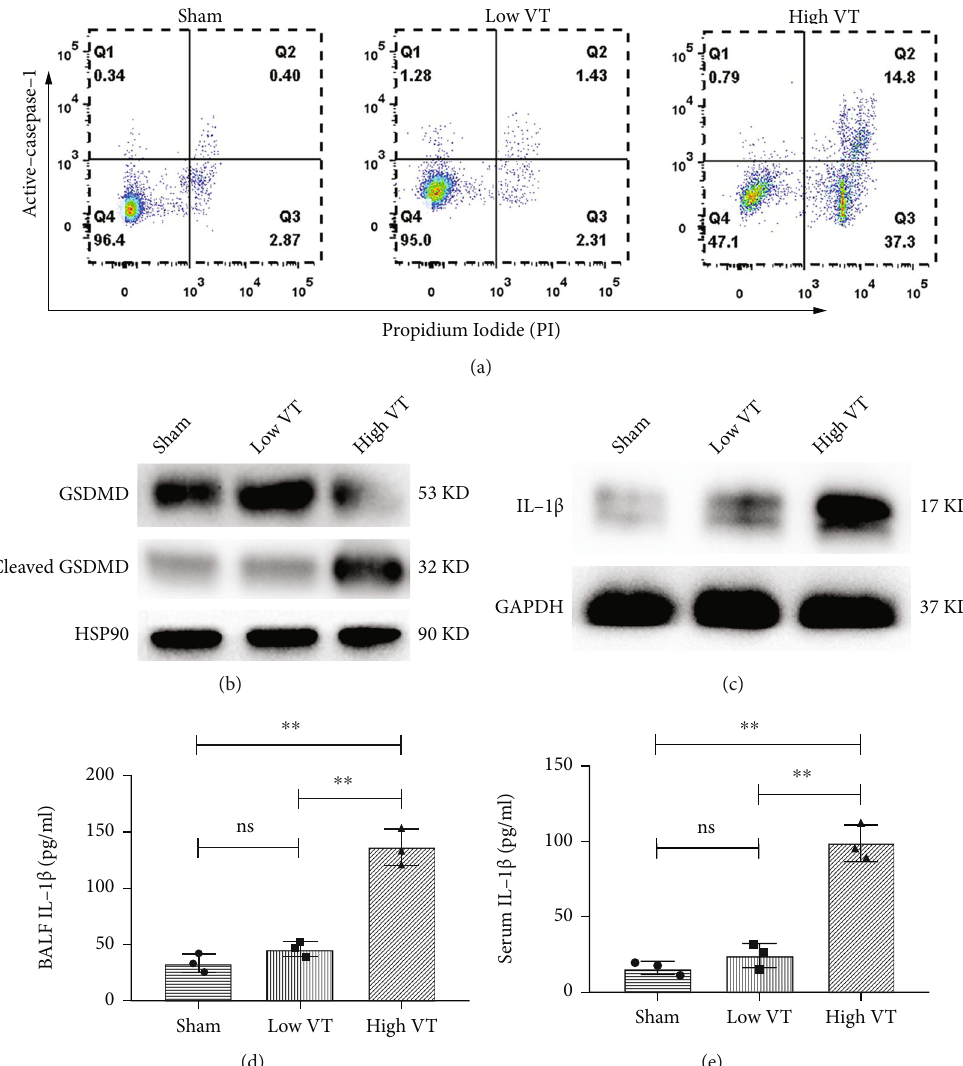
Figure 1: Ventilation with a high tidal volume induces elevated caspase-1-dependent pyroptosis in AMs. Caspase-1-related death cells detected by fl ow cytometry (a) and the protein level of GSDMD including full-length and cleaved forms (b) and mature IL-1 β (c) in alveolar macrophages were increased in high VT group compared with the group of control and low VT. The release of IL-1 β in BALF (d) and serum (e) was signi fi cantly increased after ventilation with high VT than that in the low VT group, compared with control group. Results are representative of three independent experiments; the results of one representative experiment are shown ( n = 5 /group, ∗ p < 0 : 05 , ∗∗ p < 0 : 01